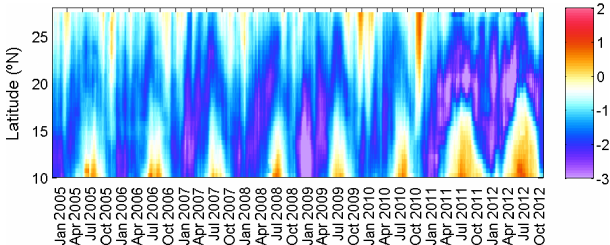
Figure 2. Time series of upwelling index (UI, × 10 − 3 m 2 s − 1 ) in the Mauritanian–Cap Vert upwelling region along the ship track computed following Nykjaer and Van Camp (1994). Blue colors are related to upwelling events and red colors to downwelling